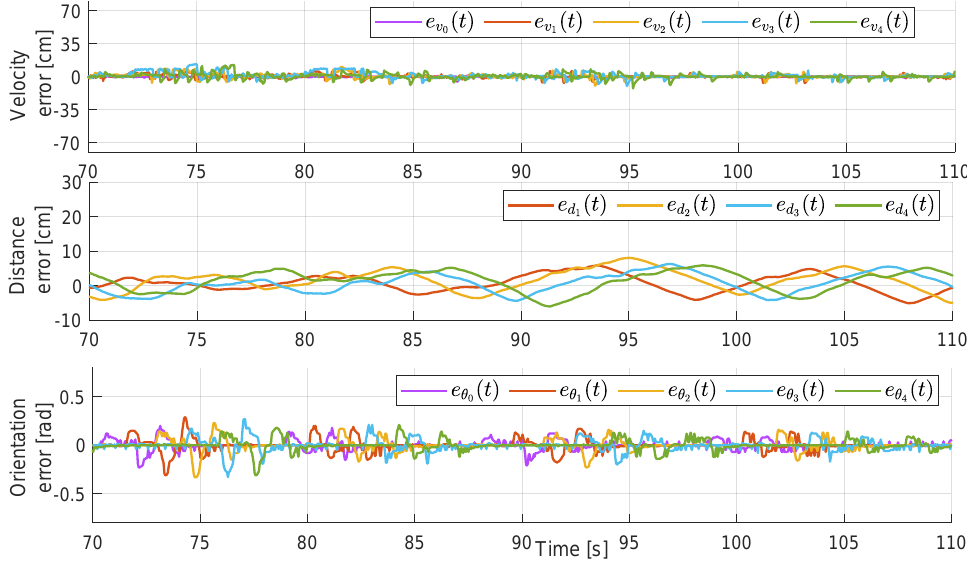
Figure 15. Errors in a time window of the experiment with the cooperative